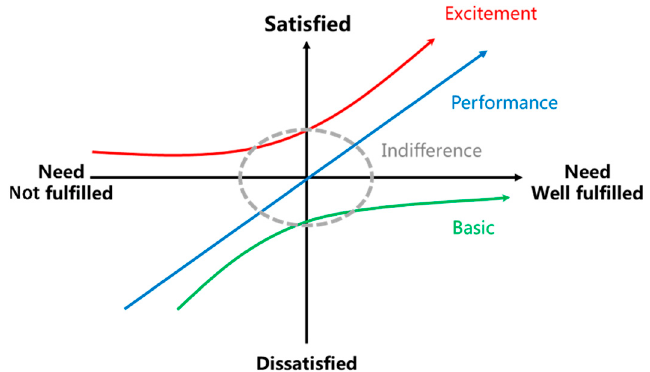
Figure 1. Kano two-dimensional quality model.